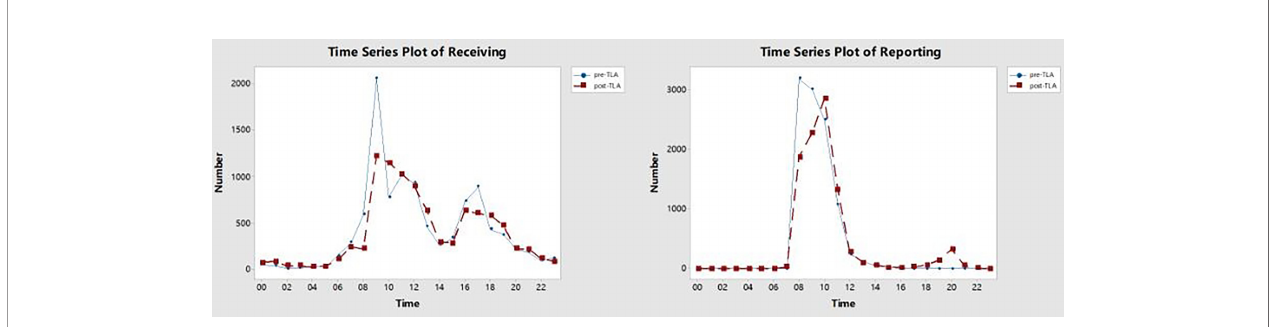
FIGURE 4 | The time series plot of receiving and reporting in pre-TLA and post-TLA. The X-axis represents the time in a 24-hour time display, and the Y-axis represents the number of receiving or reporting at each moment. TLA, total laboratory automation.